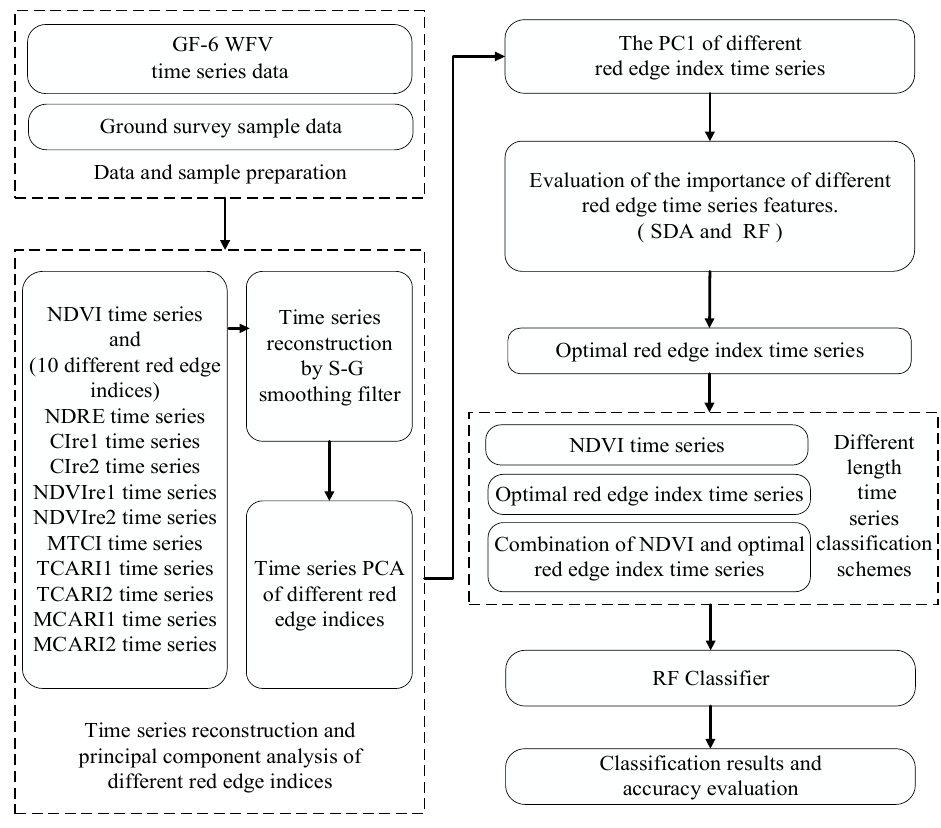
Figure 2. Technical route of the study.